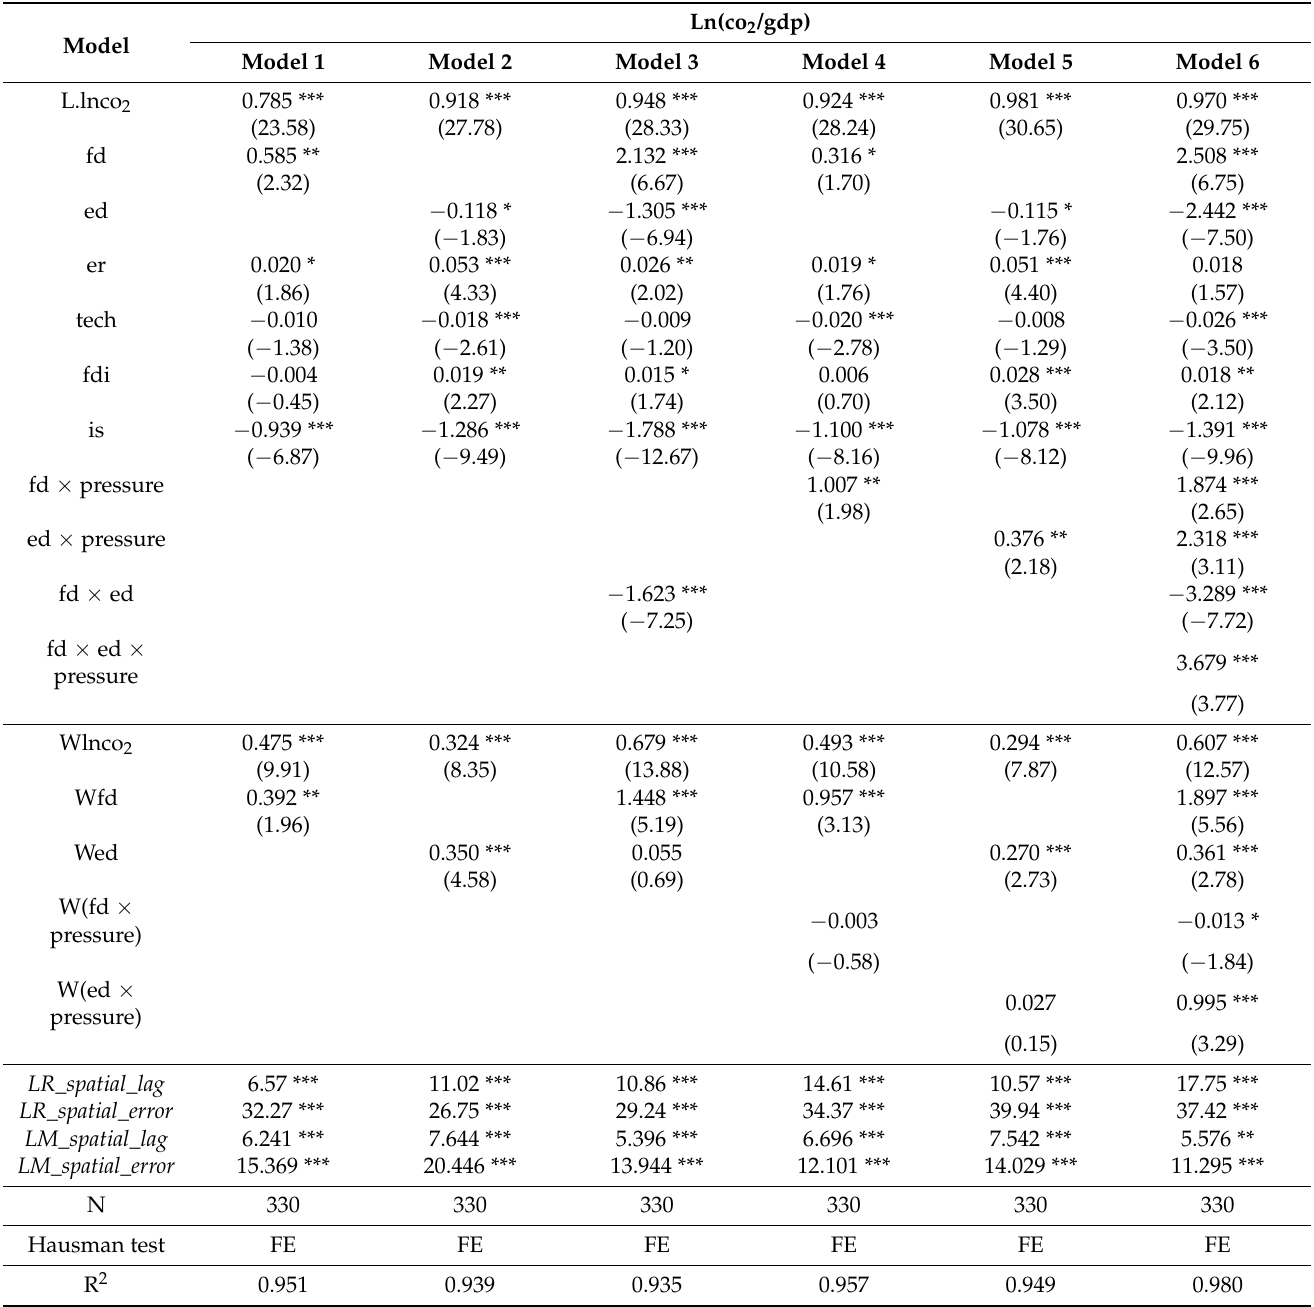
Table 4. Basic regression results for fiscal decentralization, environmental decentralization, officials’ promotion pressure and carbon